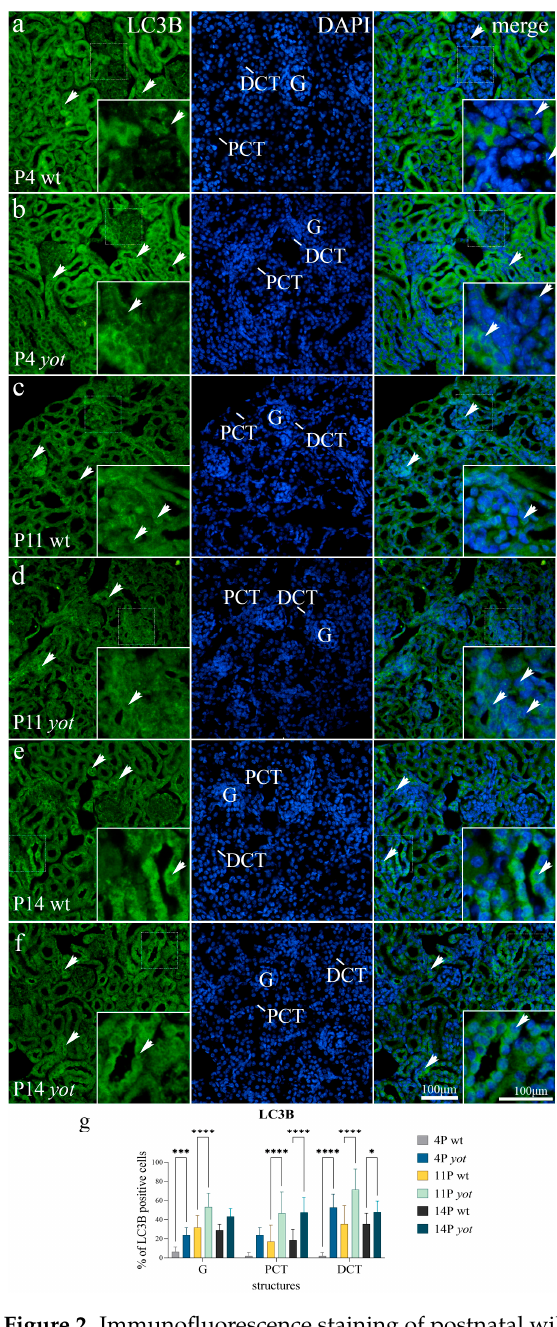
Figure 2. Immunofluorescence staining of postnatal wild-type (wt) ( a , c , e ) and yotari ( b , d , f ) mouse kidneys with LC3B marker and DAPI nuclear staining. Three mice were used for each genotype ( yotari and wt) at every observed time point. Arrows show the expression pattern of LC3B in glomeruli (G), proximal convoluted tubules (PCT), and distal convoluted tubules (DCT) indicated on the 4 ′ ,6-diamidino-2-phenylindole (DAPI) image. The most prominent protein expression area is shown in the inserts, corresponding to the dashed boxes. Images were taken at a magnification of × 40. The scale bar is 100 µ m, which refers to all images. Graph ( g ) shows the distribution of the percentage of LC3B-positive cells in the glomeruli (G), proximal convoluted tubules (PCT), and distal convoluted tubules (DCT) of postnatal kidneys of wild-type and yotari animals over time (P4, P11, P14). Data are presented as the mean ± SD (vertical line) and analyzed by a two-way ANOVA test followed by Tukey’s multiple comparison test. Significant differences are indicated by * p < 0.05, *** p < 0.0001, **** p < 0.00001. At each time point, twenty substructures were